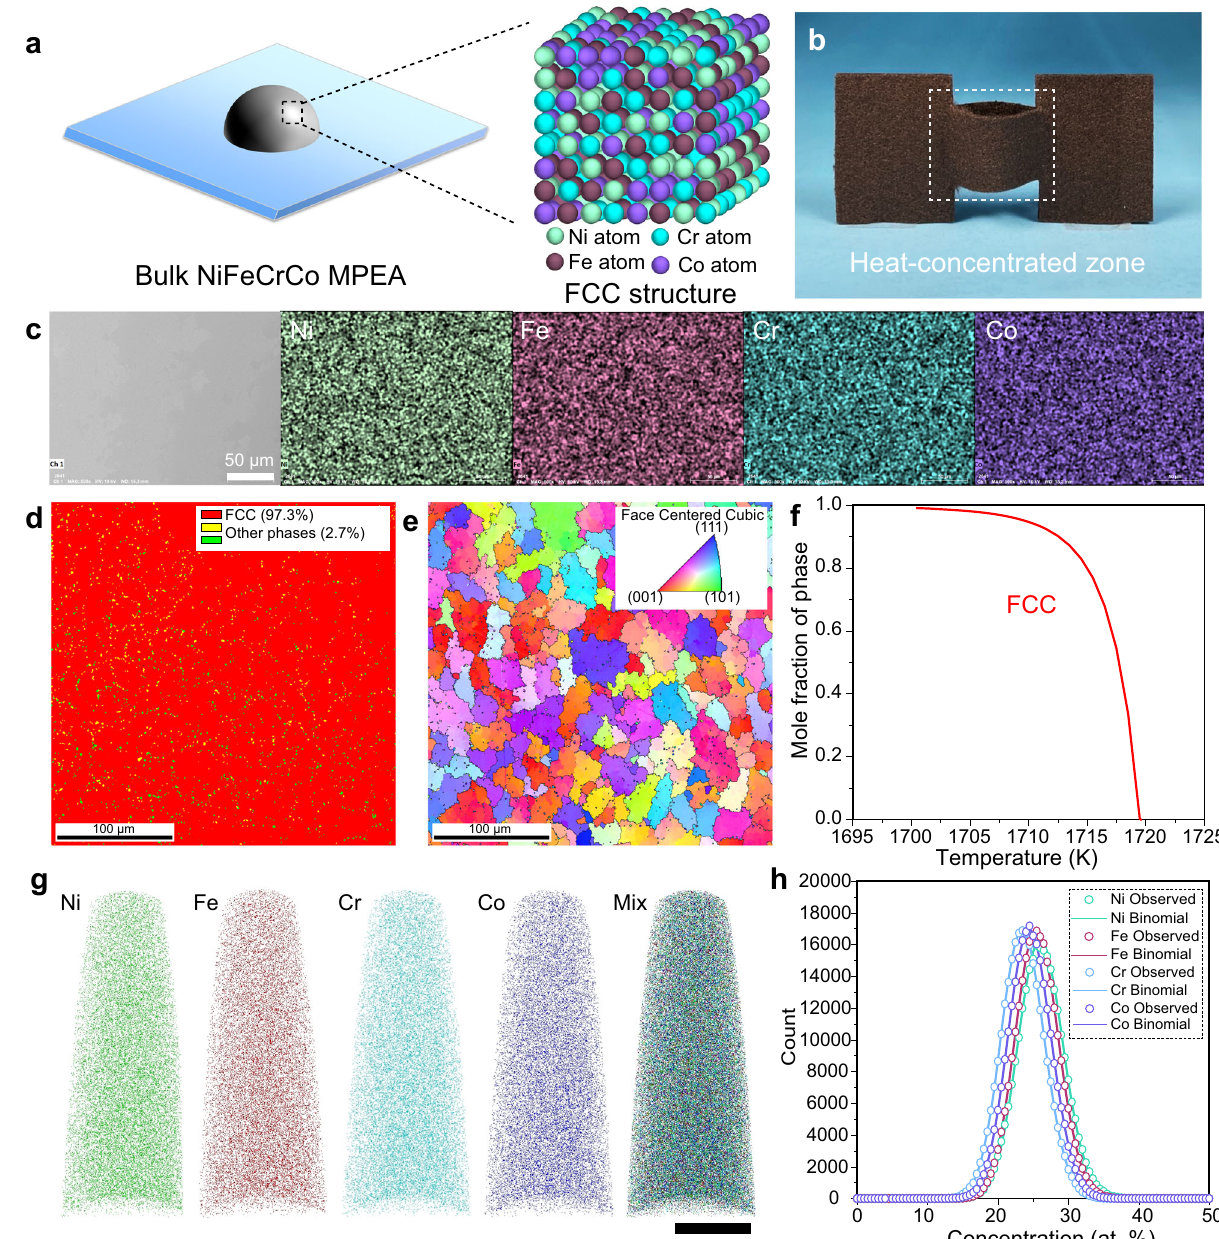
Fig. 3 | Characterization of the NiFeCrCo MPEA fabricated by the heat-con- centrated, high-temperature melt printing platform. a Schematic of forming FCCsingle-phaseNiFeCrCoMPEA. b Photographoftheheat-concentratedzonefor MPEAfabrication. c SEMandEDSoftheprintedNiFeCrCoMPEA. d EBSDimageand e grain size distribution of the NiFeCrCo MPEA. f Phase transformation path of